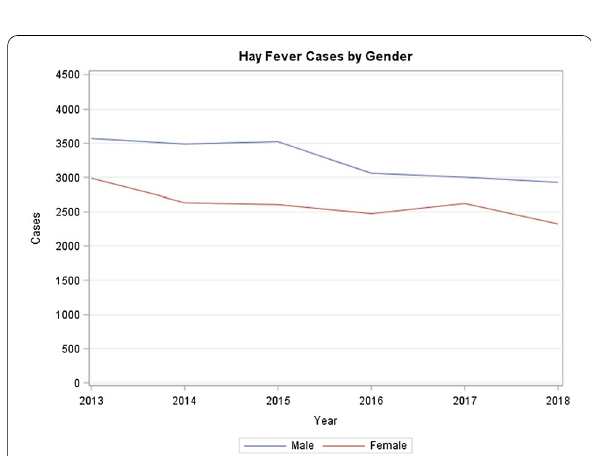
Fig. 2 Hay fever cases among children by gender (frequency in